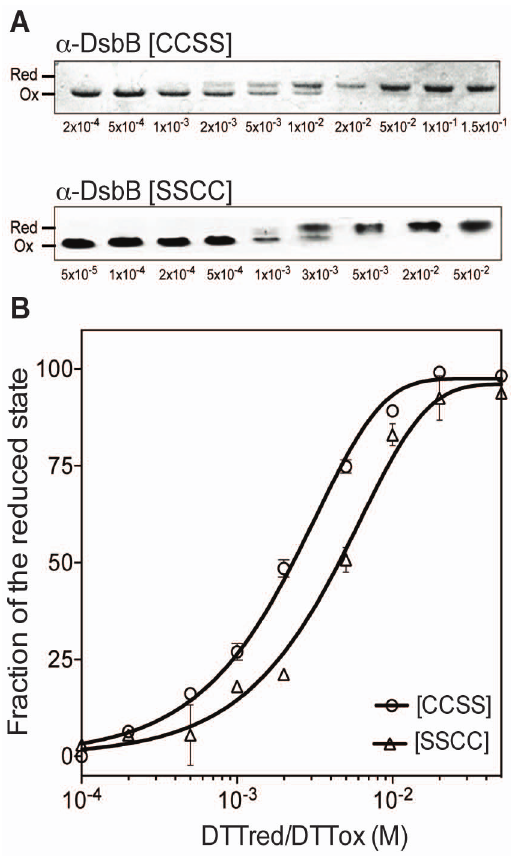
Figure 6. Redox potentials of the cysteine pairs in the P1 and P2 loops of a -DsbB. ( A ) Redox equilibria of a -DsbB [CCSS] and a - DsbB [SSCC]. After equilibration in redox buffers of varying [DTTred]/ [DTTox] ratios for 24 h, samples were treated with 10% TCA and free cysteines were labeled with AMS. Reduced and oxidized proteins were separated by 12% SDS-PAGE under non-reducing conditions. ( B ) Redox potentials of a -DsbB [CCSS] and a -DsbB [SSCC]. The fractions of a -DsbB [CCSS] or a -DsbB [SSCC] in the reduced state were calculated using ImageJ [36] and equilibrium constants were plotted against the fraction of the reduced state in PRISM H using the one phase decay option. The data presented are the standard mean and error from duplicate measurements.